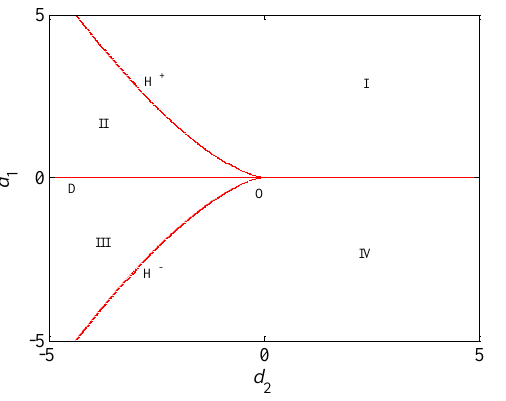
Figure 20. Transition set of nonlinear coupled vibration system of hot rolling mill rolls with d 3 = 0.